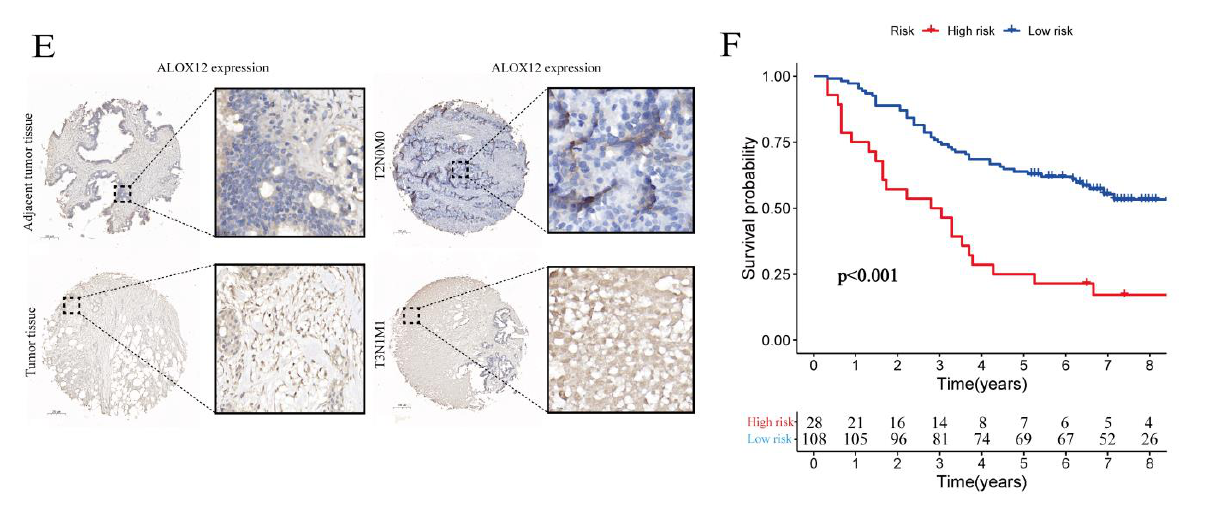
Figure 9. Evaluation of ALOX12 expression and prognosis value in clinical ovarian samples. ( A ) Immunoblot analysis of ALOX12 in OC cells. The whole cell lysates extracted from IOSE80, A2780, and HEY cell lines were subjected to Western blot analysis with the indicated antibodies. ( B ) The proliferative ability of HEY cells was detected by EdU assay. HEY cells were incubated with or without 20 uM ML355 for 8 h (mean ± SD; n = 3 biological replicates per group; ** p <